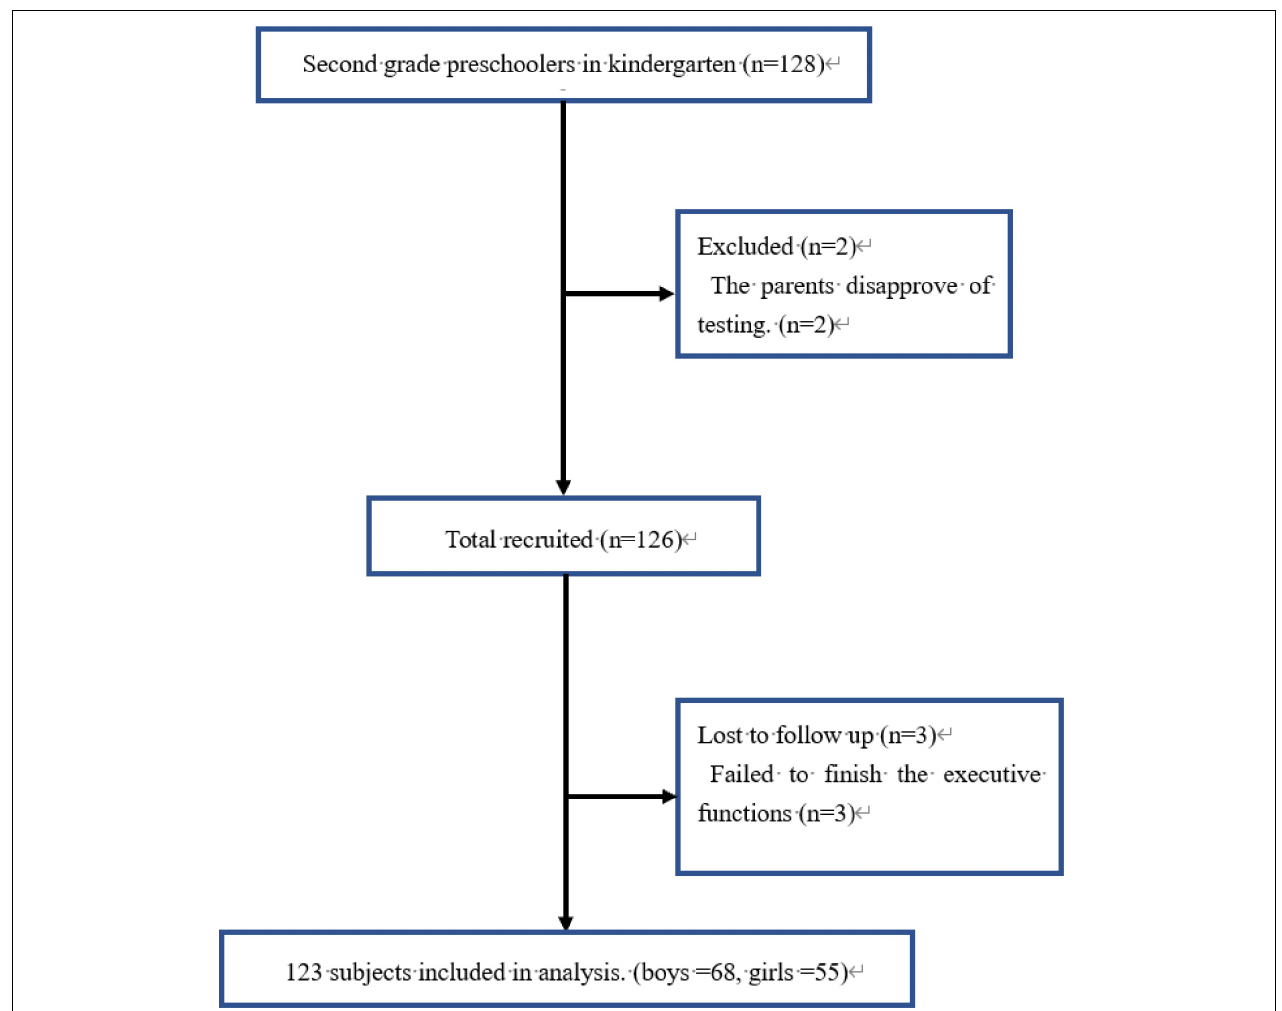
FIGURE 2 | Flowchart of the subjects in the present